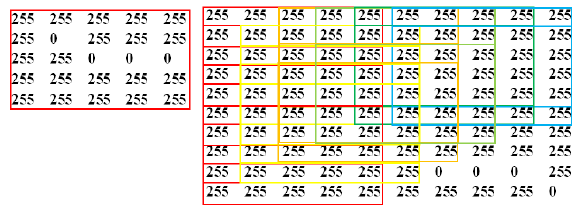
Figure 3. Floating Frames Between 2